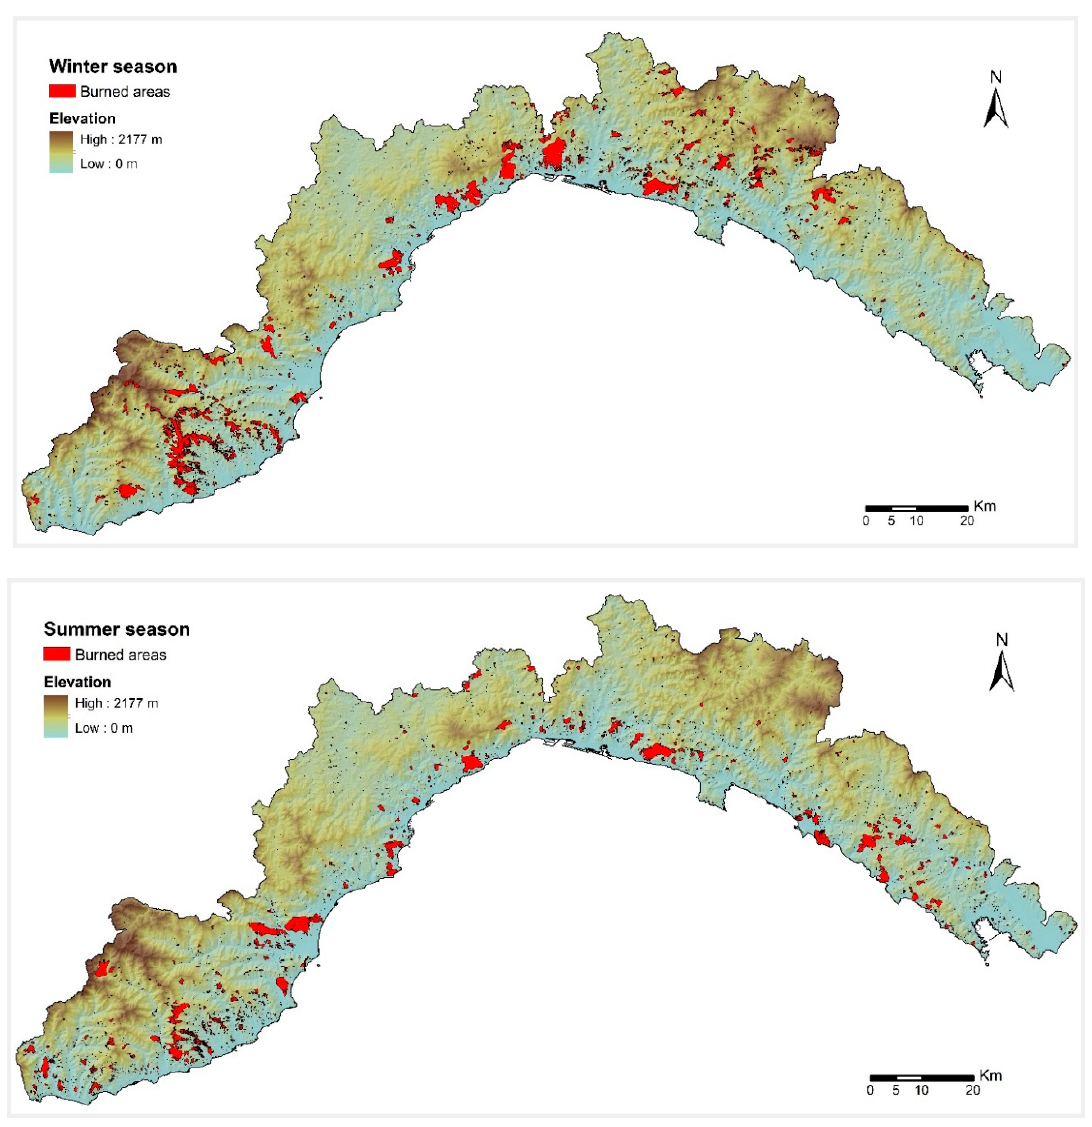
Figure 3. Spatial distribution of burned areas during the winter (on the top) and summer season (on the bottom) in the Liguria region (Italy) during the period 1997–2017.